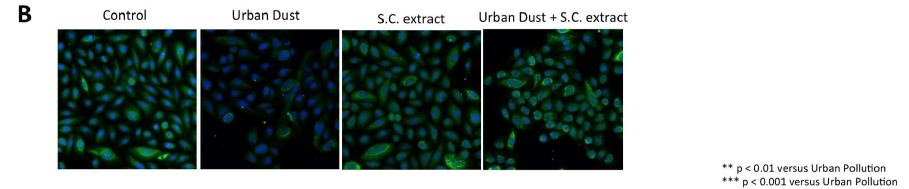
Figure 4. ( A ) The effect of S.C . extract on SOD2 expression and catalase activity in the NHEK that were exposed to Urban Dust (80 μg·mL −1 ). ** p < 0.01 and *** p < 0.001. UB: Urban Dust ( B ) Representative pictures of SOD2 expression: SOD2 in green, Nucleus in blue.